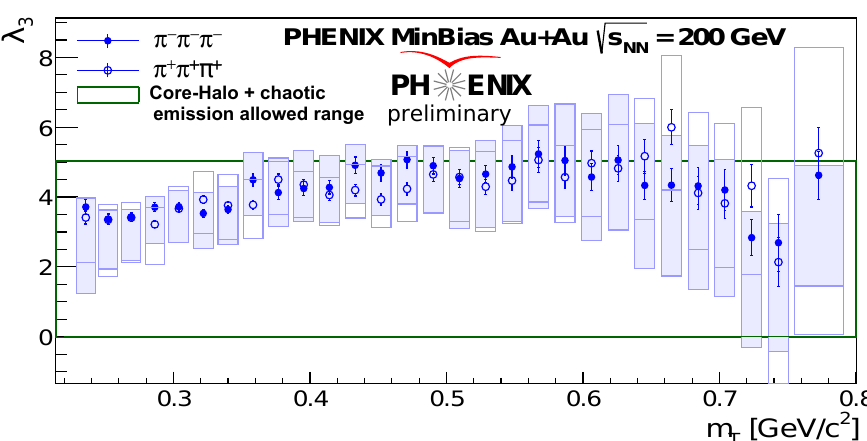
Figure 2. The three-particle correlation strength, λ 3 , as a function of m T . Statistical and systematic uncertainties are shown as bars and boxes,